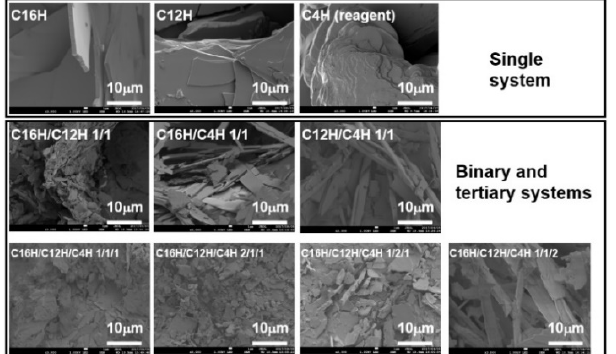
Figure 7. SEM images of the single and mixed xerogels obtained from molecular gels with n -octane as the solvent.